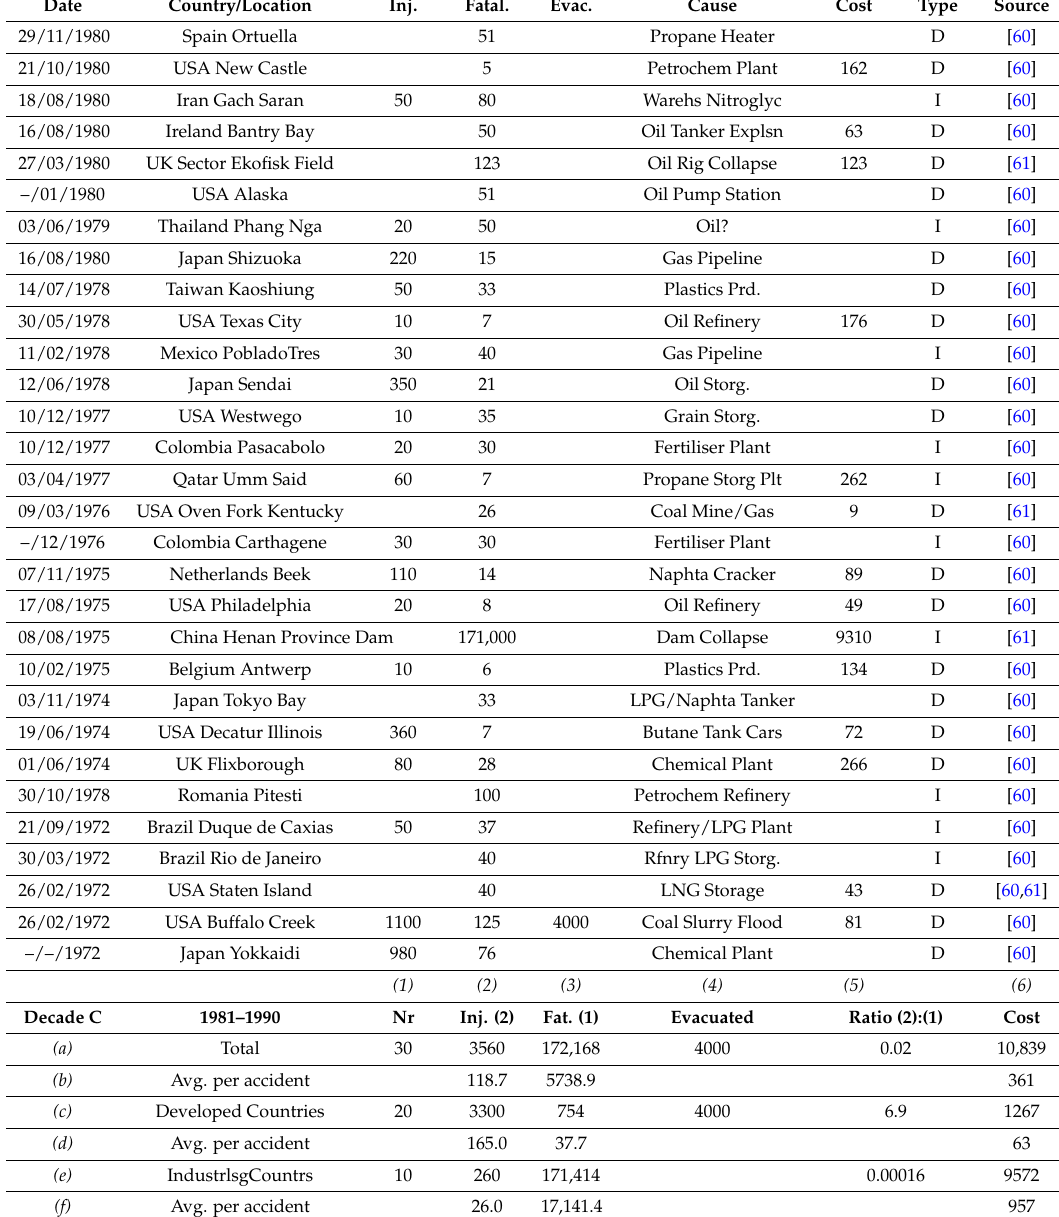
Table 4. Period D,